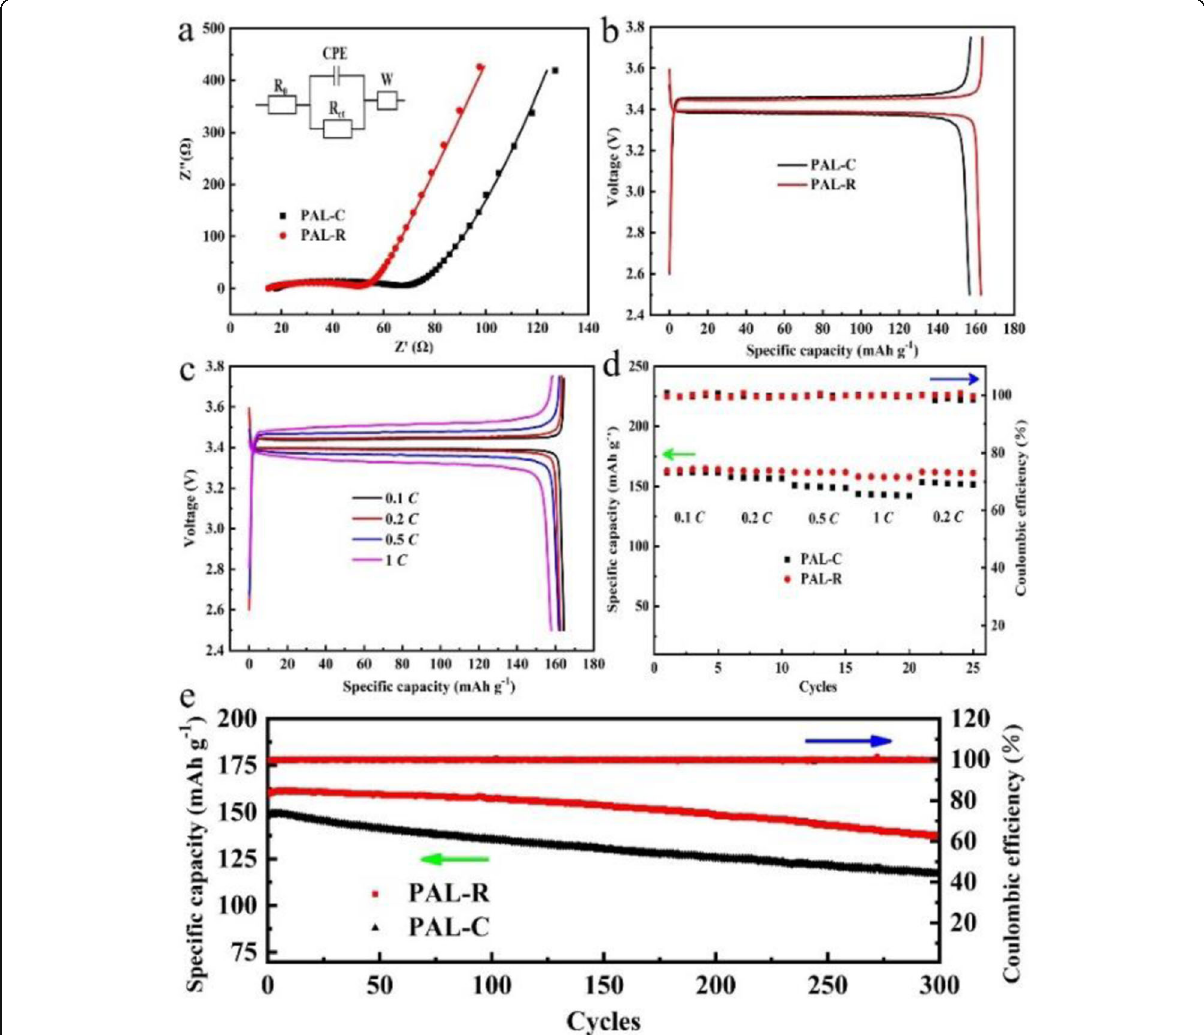
Fig. 3 a EIS plots and simulated results for LFP/SPE/Li batteries with different SPEs (inset: the equivalent circuit model), b discharge-charge performances of LFP/SPE/Li batteries with different SPEs at 0.2 C , c discharge-charge curves of LFP/SPE/Li battery with PAL-R SPE at different current densities, d rate performance; and e long-cycle performance of LFP/SPE/Li batteries with different